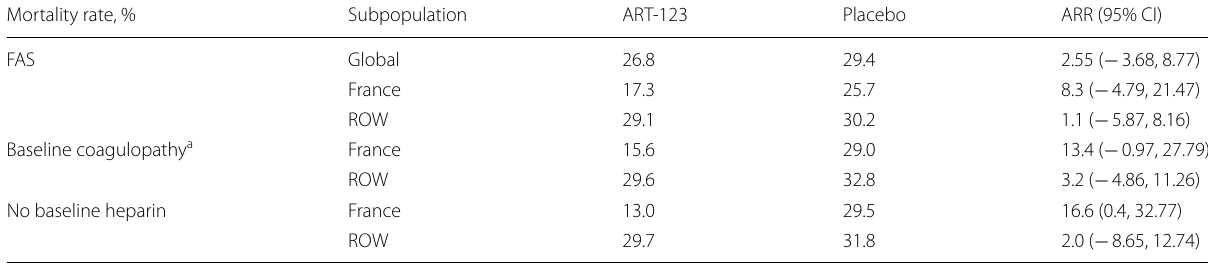
Table 3 Efficacy of ART‑123 vs placebo in France and ROW Mortality rate, %